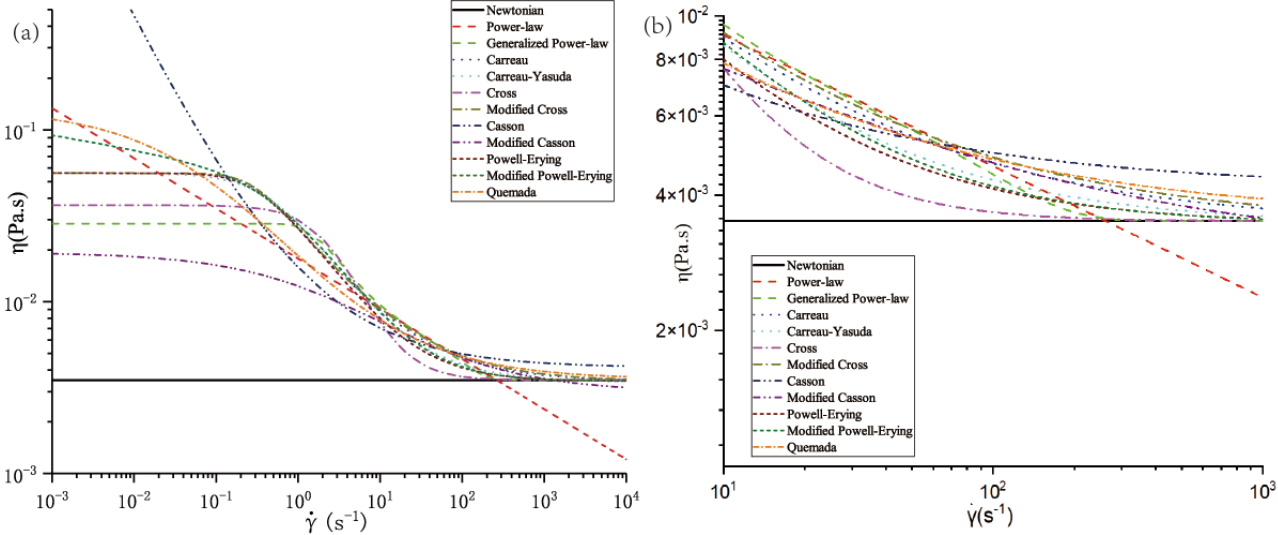
Figure 6. ( a ) Viscosity for different rheological models with ( b ) details of the zone of interest. Table 1. Non-Newtonian viscosity models of blood